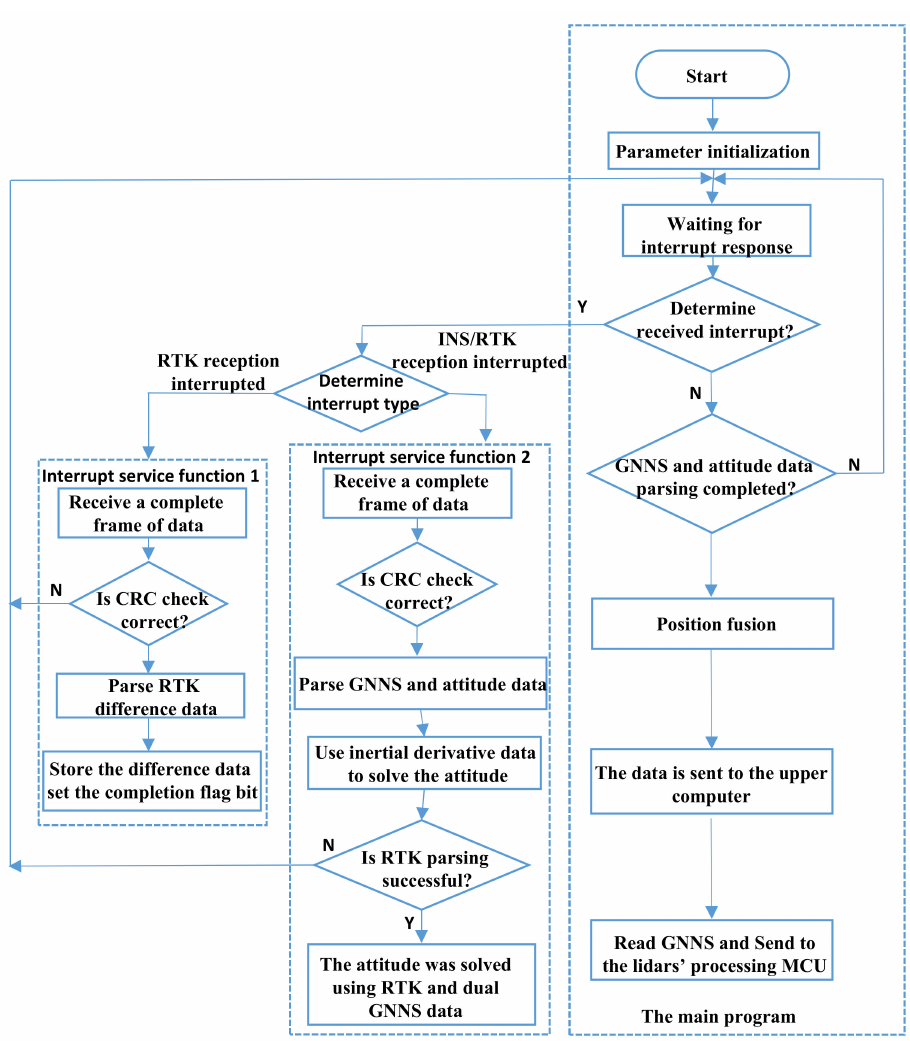
Figure 3. Data synthesis processing MCU program design flow